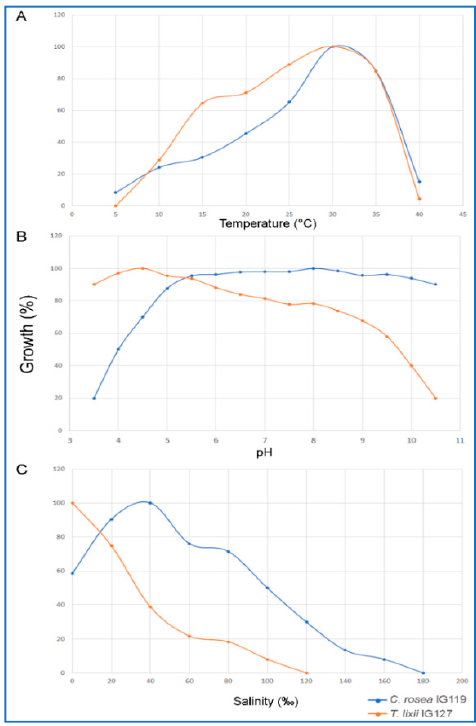
Figure 2. Growth of Trichoderma lixii IG127 and Clonostachys rosea IG119 in agar media at different values of temperature ( A ), pH ( B ) and salinity ( C ). Data are reported as percentage of maximum growth.